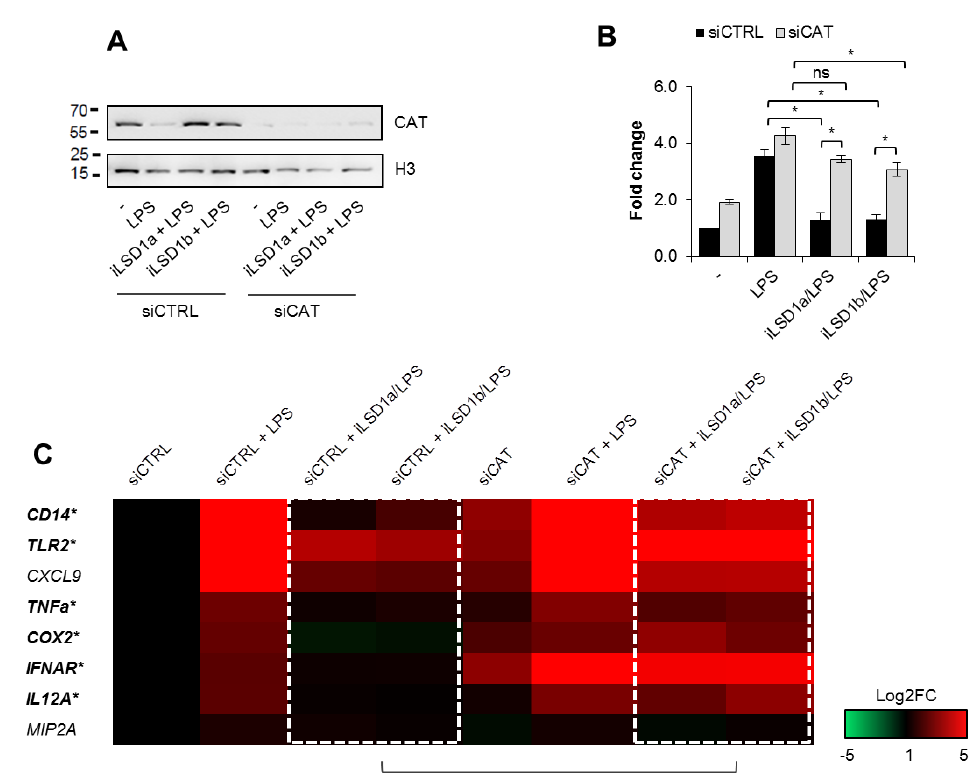
Figure 6. LSD1-induced suppression of catalase facilitates the obtention of some pro-inflammatory markers in M1-polarizing cells. To test the possible role of catalase in M1 polarization the LSD1- induced CAT repression was prevented with iLSD1a and iLSD1b (0.1 µ M SP2509, 0.1 µ M GSK-LSD1, respectively; added for 2 h prior to LPS), and the mRNA of some M1 markers was quantified (real-time PCR) and compared between cells with the maintained and decreased level of catalase (siCTRL vs. siCAT). ( A ) The efficiency of catalase silencing by siCAT in the presence and absence of iLSD1a/b was tested by Western blot 48 h after cell transfection with siRNA. Inhibitors were added 46 h after cell transfection and for 2 h prior to LPS (10 ng/mL). Cell lysates were collected 24 h after cell stimulation with LPS. ( B,C ) The same experimental setting were applied to testing some cytokines and other M1 markers. ( B ) IL1 β is shown as an example. ( C ) Bolded gene names marked with stars indicate genes repressed by catalase during M1 polarization (significant difference in the mean when p < 0.05 between siCTRL + iLSD1a/LPS and siCAT + iLSD1a/LPS, as well as between siCTRL + iLSD1b/LPS and siCAT + iLSD1b/LPS). Western blots show representative images from three independent experiments. Bars in the figures represent mean ± standard error of the mean (SEM). One-way analysis of variance (ANOVA) was carried out in GraphPad Prism 5 to compare means in several groups and the differences between each two groups were tested with the Tukey post hoc test (marked with * when p > 0.05, with ns when p >